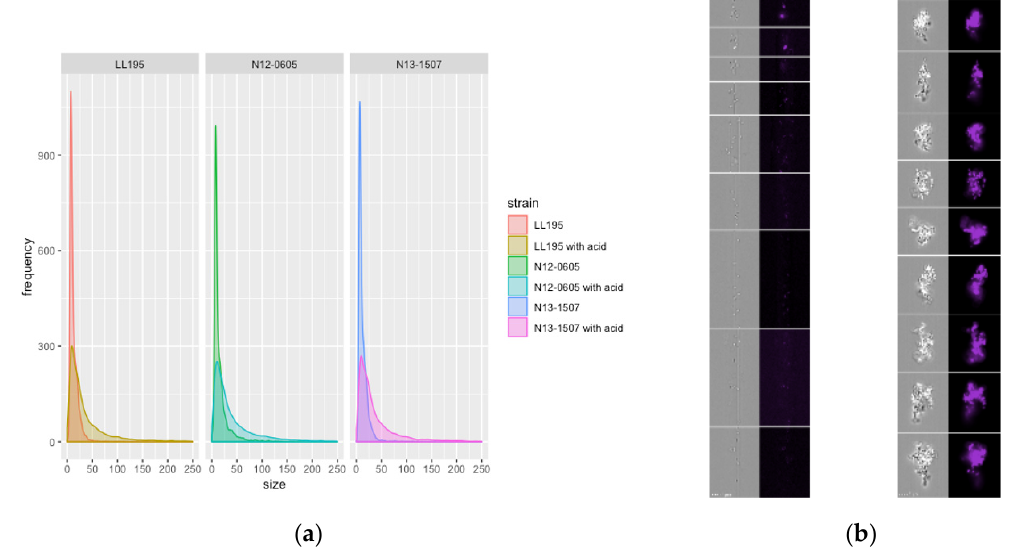
Figure 2. Morphological changes after HCl acid stress. ( a ) Flow cytometric analysis of cell size with and without acid. Each dataset represents 10’000 cells. ( b ) Image stream analysis of L. monocytogenes cells without (left) and with (right) acid stress. For each dataset, 10,000 cells were imaged. The figure contains representative images (left column: brightfield; right column: DAPI) from among the largest entities within each dataset.